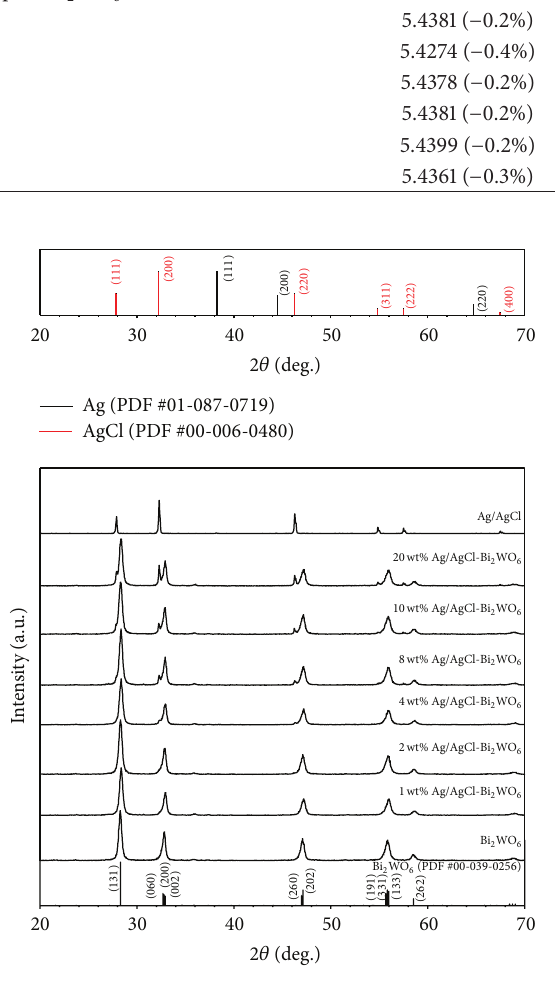
Figure 1: XRD patterns of as-prepared samples: pure Bi 2 WO 6 , Ag/AgCl, and Ag/AgCl-Bi 2 WO 6